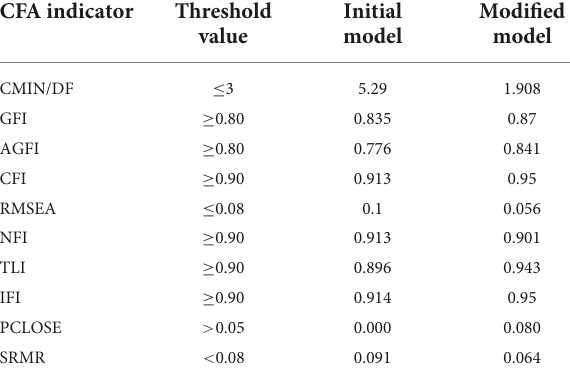
TABLE 4 Measurement model fitness values.